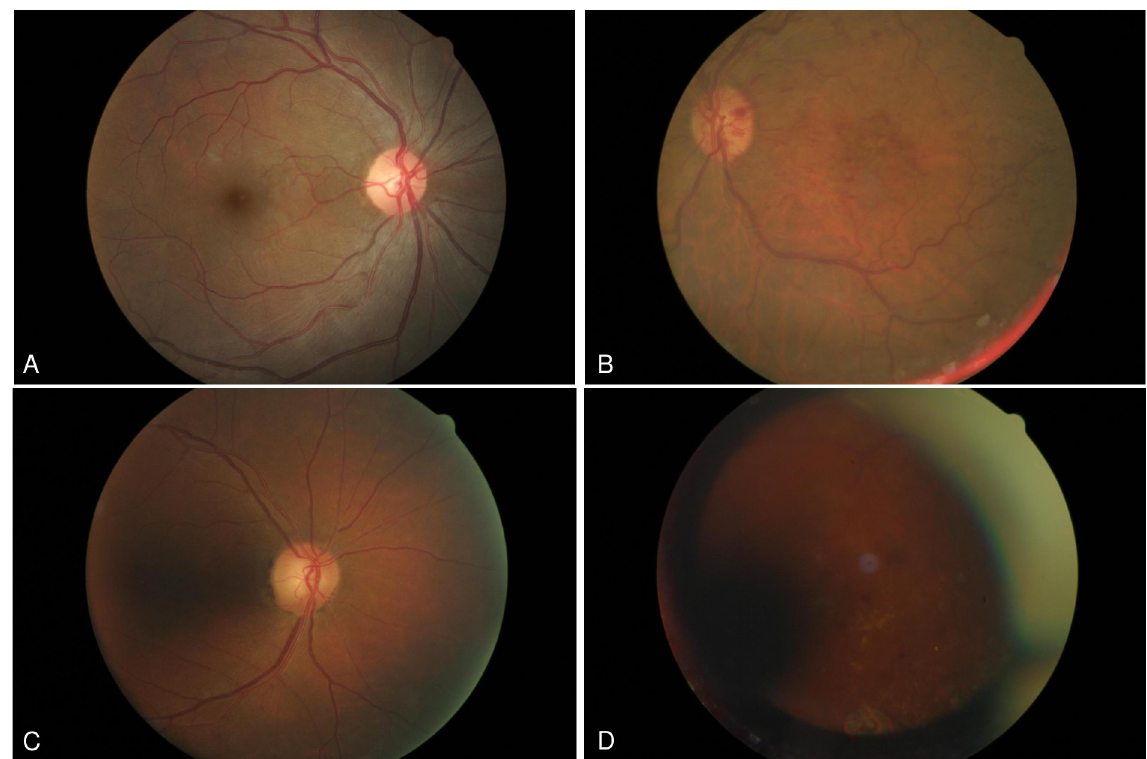
Fig 1. Representative color fundus images from the Excellent (A), Good (B), Adequate (C) and Insufficient for grading (D) categories. Image 1B fulfills criteria for “Good” due to the image field definition (decentered image) and peripheral artifacts; 1C qualifies as Adequate due to its poor illumination, off focus and due to insufficient image field definition (the image field does not contain enough of the retina temporal to the fovea). Image 1D was labelled as Insufficient as it neither depicts the optic nerve head nor makes it possible to visualize the third-generation vessel branches around the macula which, in turn, would not enable to detect retinal changes characteristic for diabetic retinopathy.